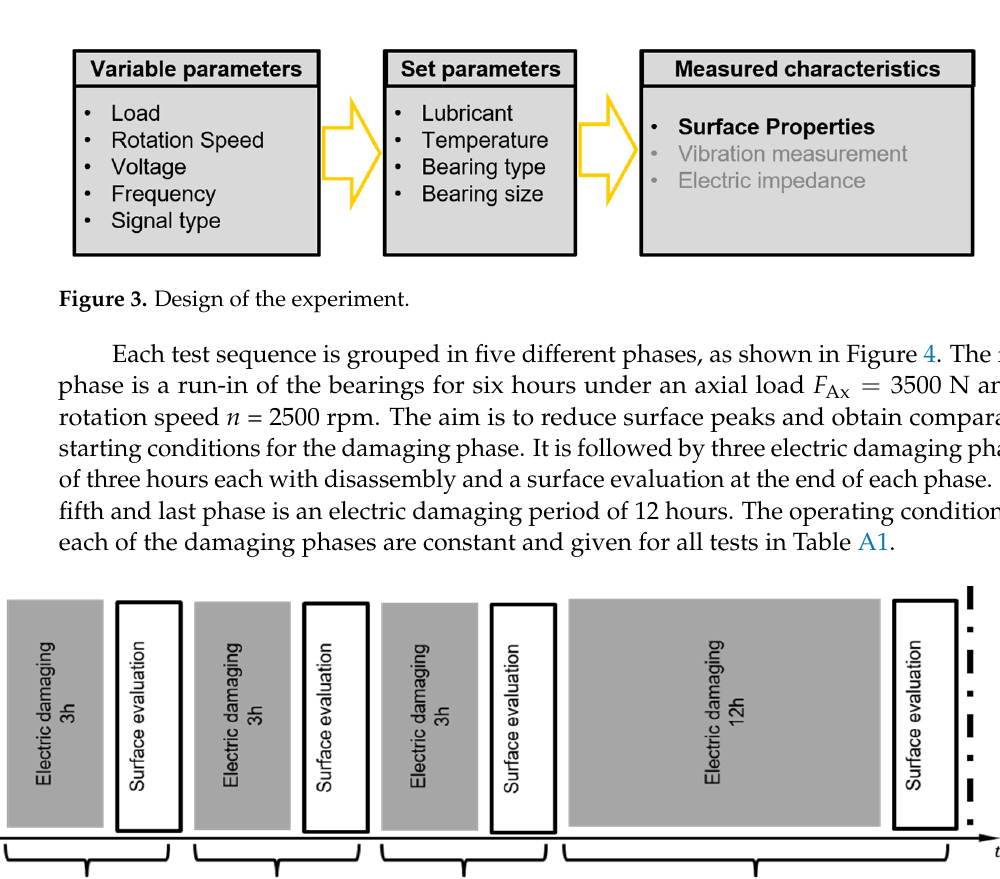
Table 2. Constant parameters.